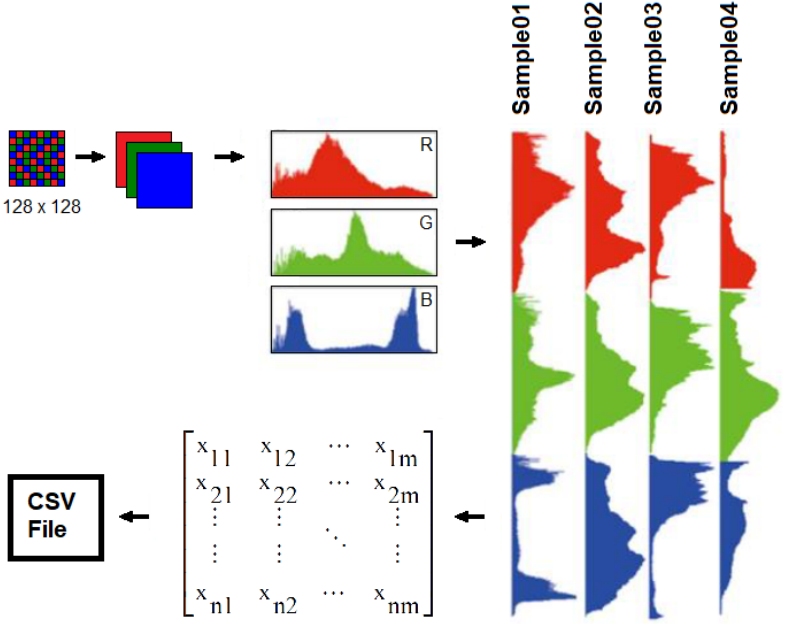
Figure 4. Processing to generate CSV file from matrix of histograms. Algorithm 1 shows the procedures developed for the acquisition and processing of images and the prediction of clay